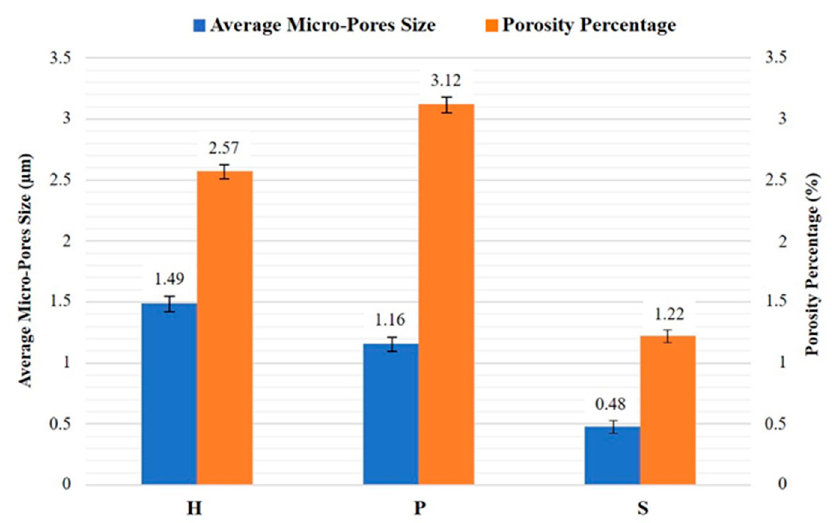
Figure 5. Average size of micropores and percentage of porosity of PEO coatings in various electro- lytes.